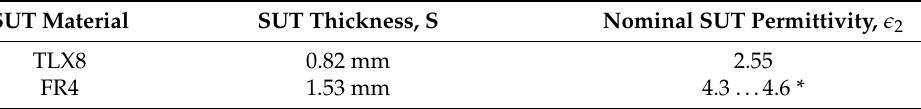
Table 2. Sample under test (SUT) values used in